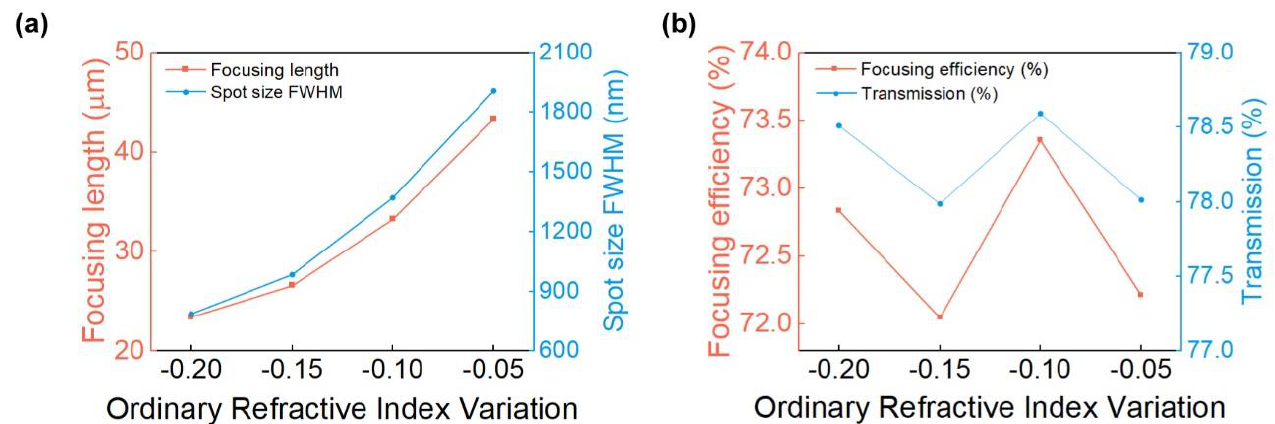
Figure 4. Characterization and comparison of metalens focusing function. ( a ) Comparison of focusing length and focal spot size FWHM of metalens under four voltage groups; ( b ) Comparison of focusing efficiency and transmission ratio of metalens under four voltage groups. The horizontal axis represents ∆ n omax , which is the maximum ordinary refractive index variation caused by voltages in each group. This representation gives a more direct view of the voltage corresponding to different sets of metalens.